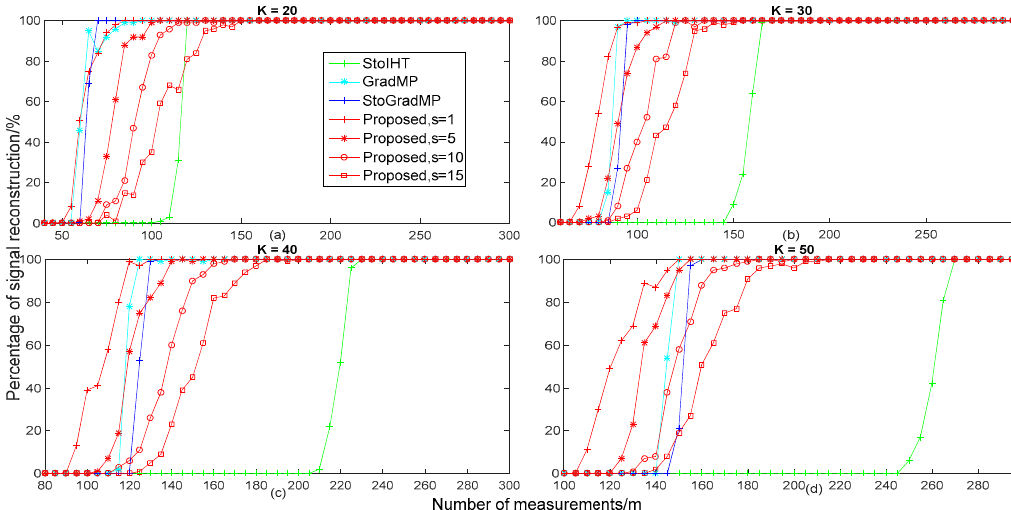
Figure 6. Reconstruction percentage of different algorithms with different measurements in different real sparsity K conditions ( n = 400, s ∈ [ 1,5,10, 15 ] , δ K = 0.1 and m = 2 ∗ K : 5 : 300, Gaussian signal).